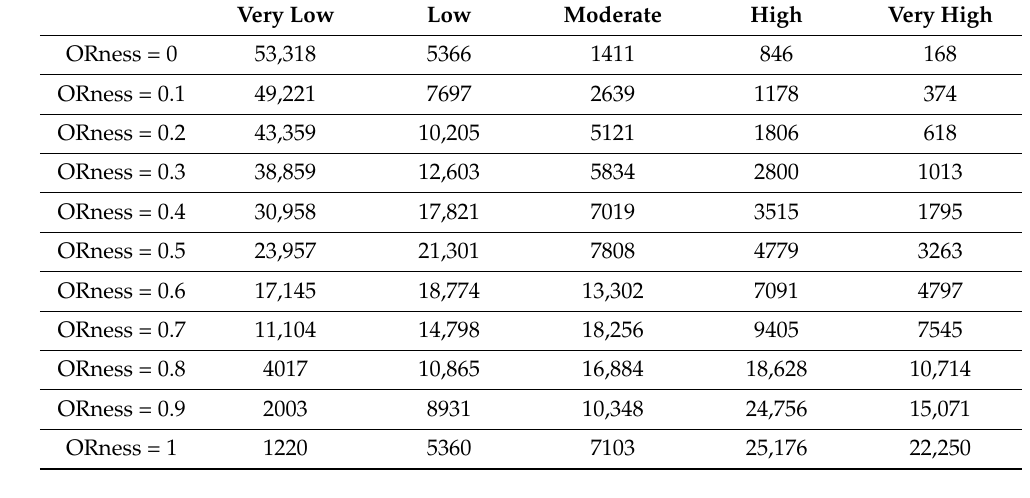
Table 4. Areal coverage of different vulnerability scenarios across different ORness